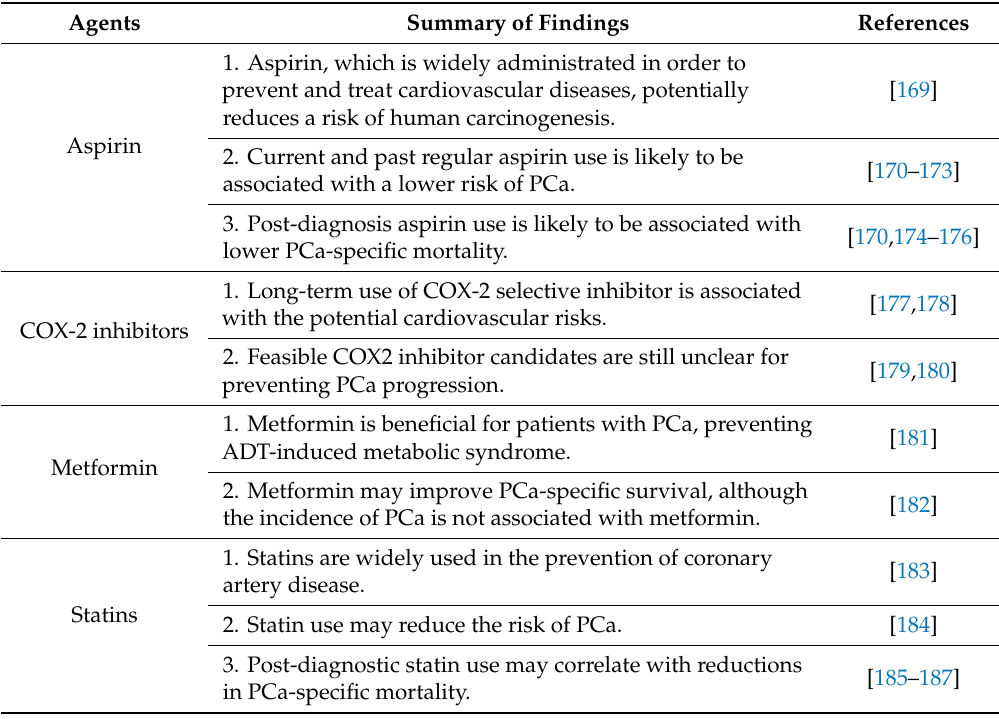
Table 1. Overview of potential applications of anti-inflammatory agents in chemoprevention of